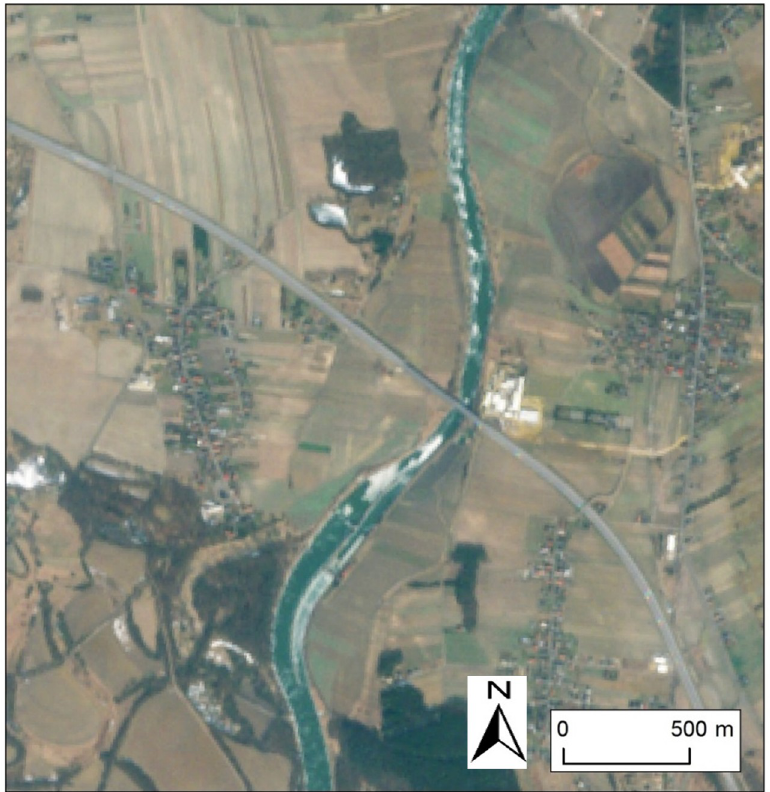
Figure 13. Sentinel-2B image acquired for the Oder River on 2 February 2018. The bridge crosses the river at 50°30′53.34″ N, 17°57′16.78″ E.